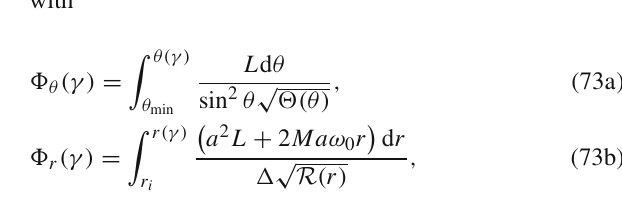
Fig. 12 The capturing trajectory for the case of ˜ η < 0, plotted for √ ω = 10 0